Question: Give a one-sentence summary of this figure.
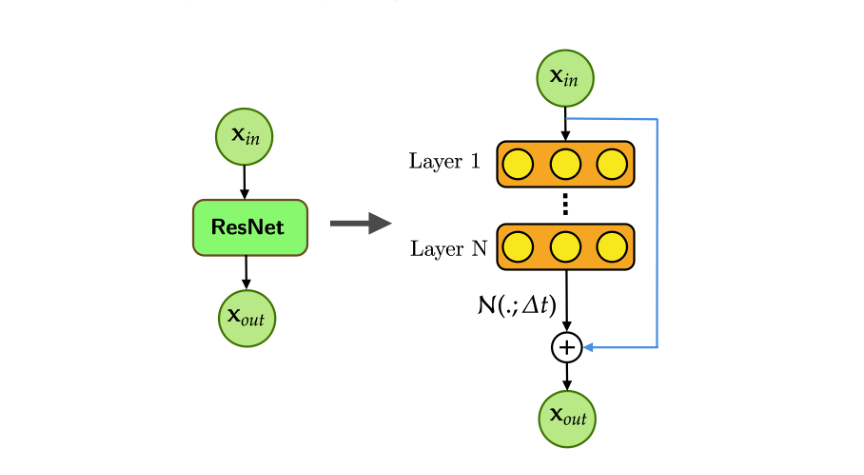
Answer: Schematic for one step approximation using ResNet